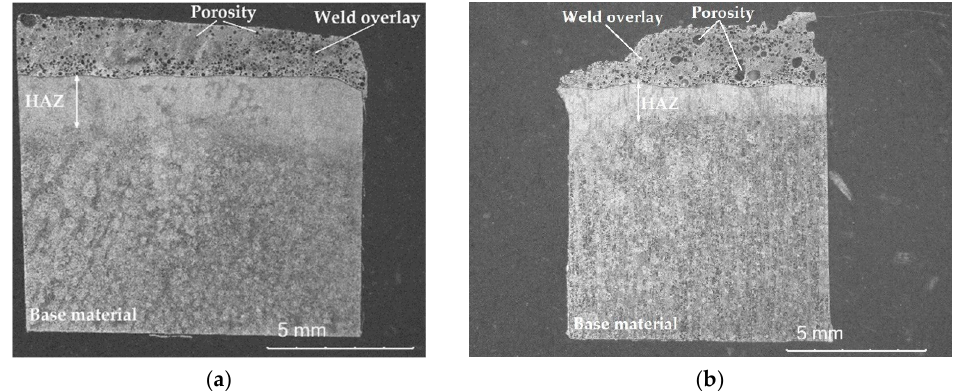
Figure 5. Exemplary macroscopic image of the longitudinal section of a composite surfacing weld: ( a ) C1 filler material; ( b ) C3 filler material.